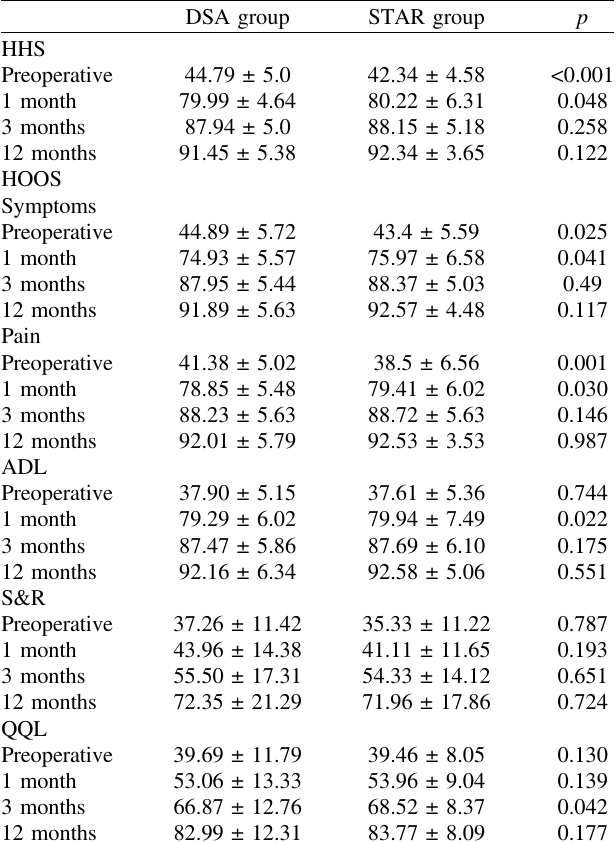
Table 3. Preoperative and postoperative outcomes data given as mean ± standard